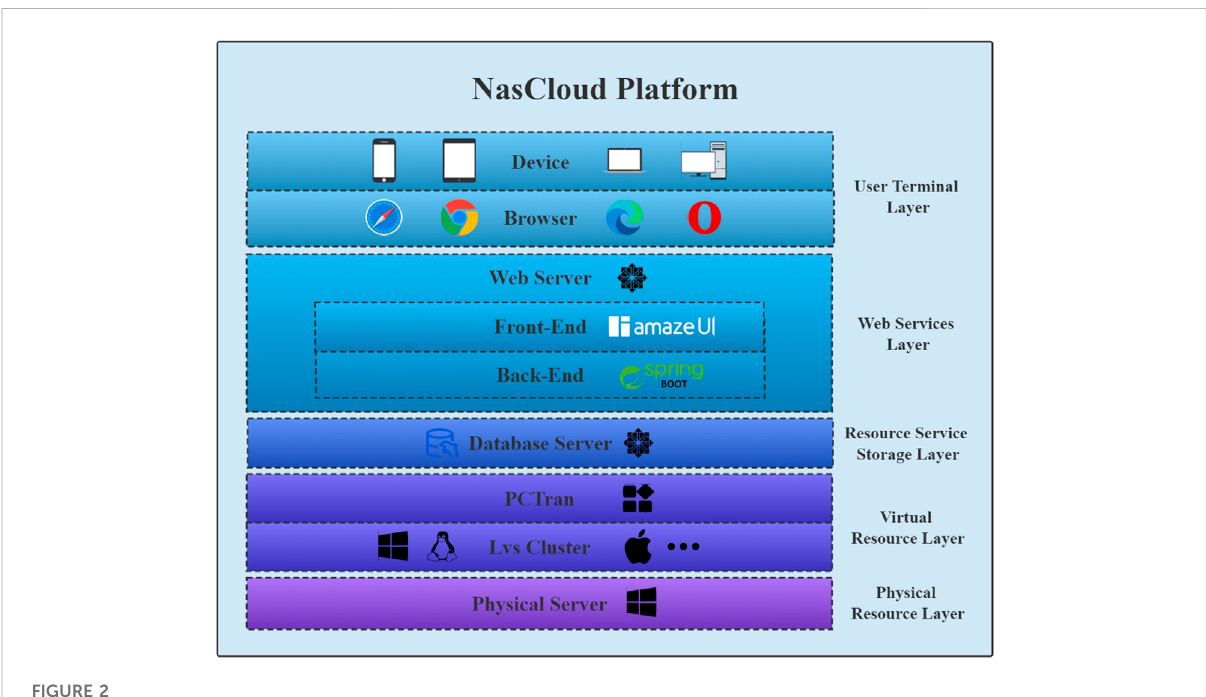
FIGURE 2 Architecture diagram of platform